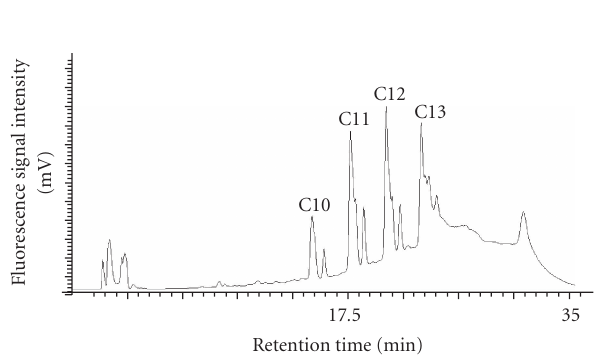
Figure 3: HPLC-FLD chromatogram obtained for carrot sample spiked with LASs (50 μ gg − 1 dry matter). Chromatographic condi- tion: Inertsil ODS3 colum of 250 × 4 . 6 mm (5 μ g), flow rate = 1.5mL min − 1 , fluorescence detection (ex: 225 nm–em: 305 nm), 20 μ L of injection